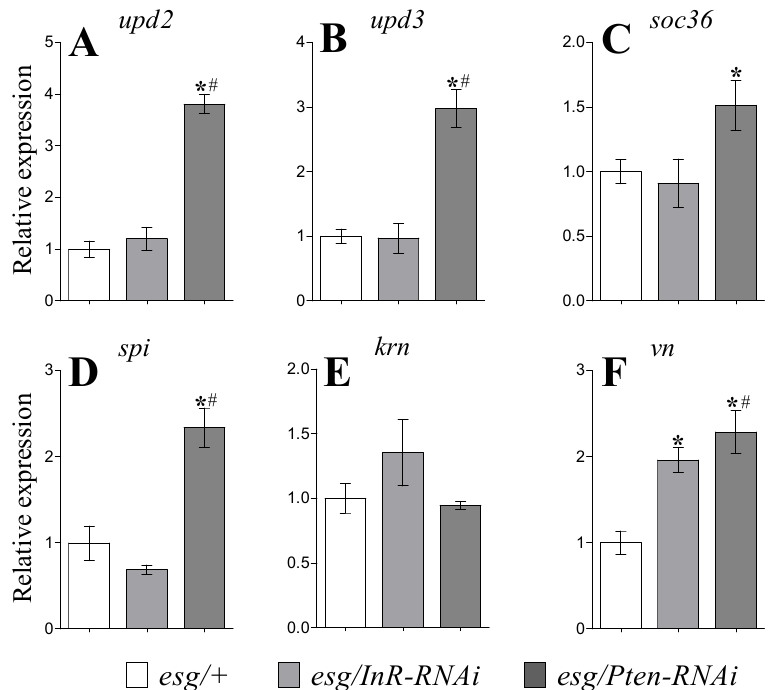
Figure 5. Expression of genes related to JAK–STAT and ligands for EGFR in the gut. Transcriptional levels of cytokine-inducing genes upd2 ( A ), upd3 ( B ), and the downstream target soc36 ( C ) were measured, as well as those for spi ( D ), krn ( E ), and vn ( F ). Flies were tested after six days after expression induction at 29 °C. Data represent mean values for 4 independent measurements (± SEM). Group comparisons were performed using ANOVA followed by Newman–Keuls post hoc test. Asterisks indicate significant difference from the control flies ( esg/+ ) ( p < 0.05); hash signs show significant difference from flies with inhibited IIS ( esg/InR-RNAi ).